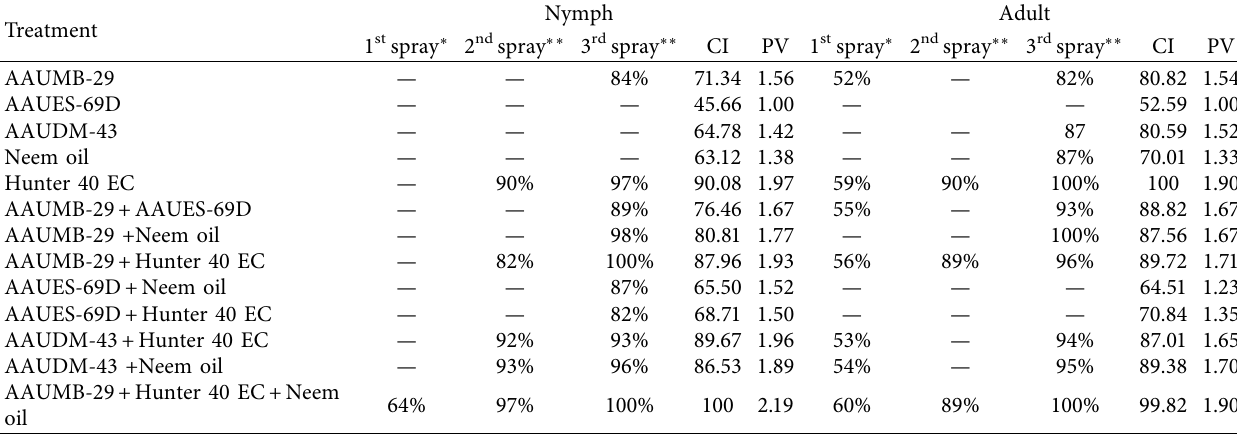
Table 3: The effects of single and combined application of biopesticides in the reduction of nymph and adults (%) of the whitefly T. vaporariorum on the Galilea tomato variety.